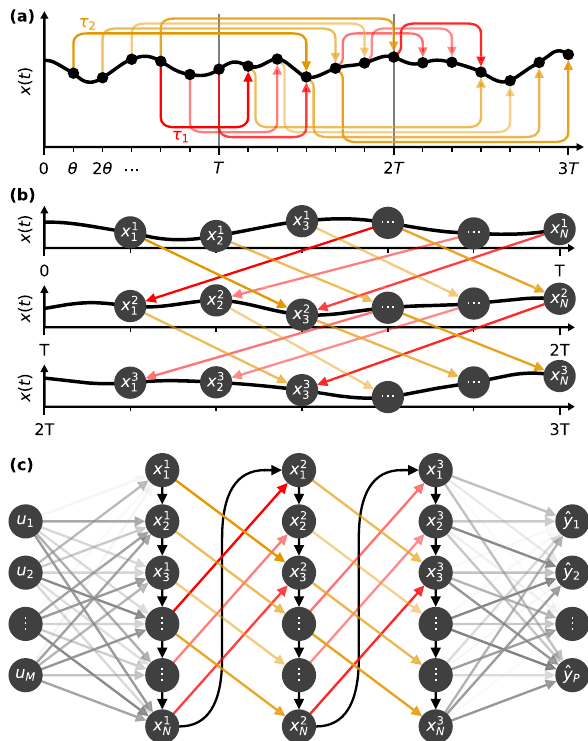
Fig. 2 Equivalence of the Fit-DNN using a single neuron with modulated delayed feedbacks to a classical DNN. a The neuron state is considered at discrete time points x ‘ n : ¼ x ðð ‘ (cid:2) 1 Þ T þ n θ Þ . The intervals ð ‘ (cid:2) 1 Þ T ;‘ T ð correspond to layers. Due to delayed feedbacks, non-local connections emerge (color lines). b Shows a stacked version of the plot in ( a ) with the same active connections. c Shows the resulting network: it is a rotated version of ( b ), with additional input and output layers. Black lines indicate connections implied by the temporal ordering of the